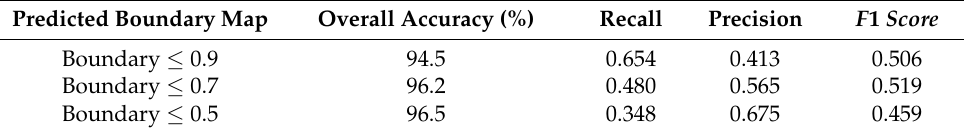
Table 4. Accuracy assessment of visible land boundary detection with U-Net.